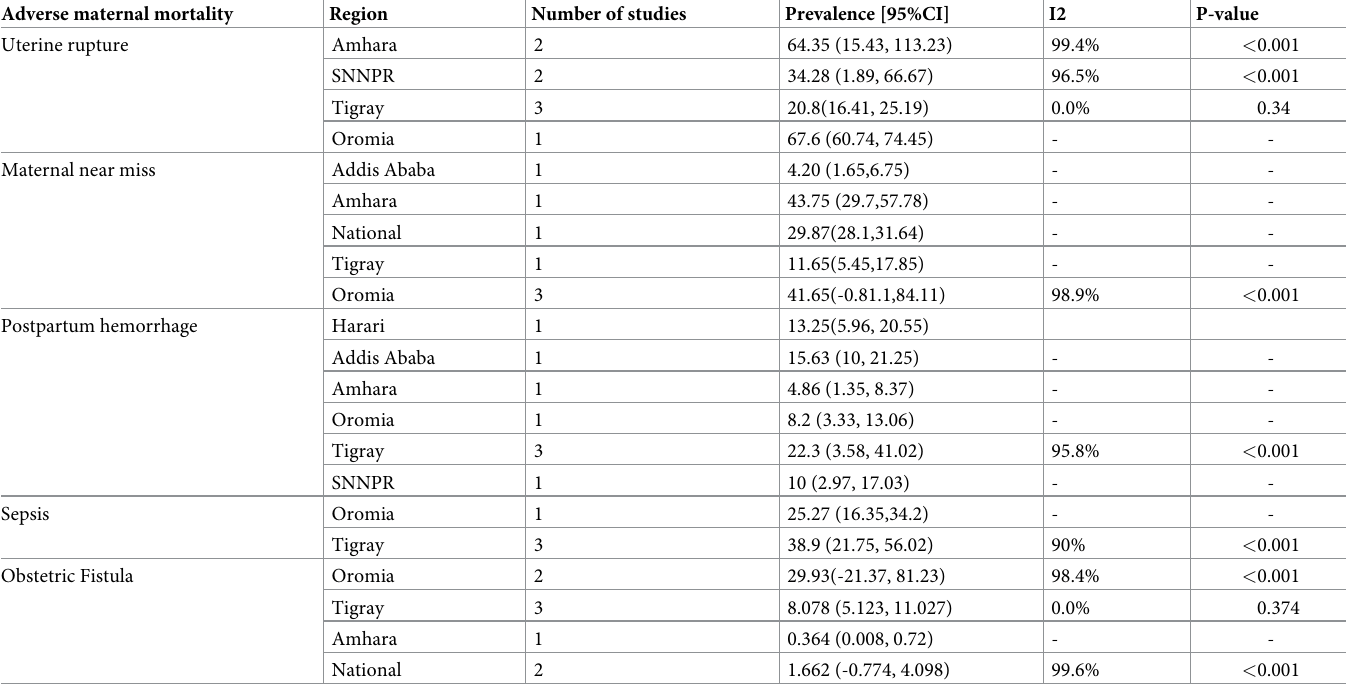
Table 1. Subgroup analysis of adverse maternal morbidity due to obstructed labor by region in